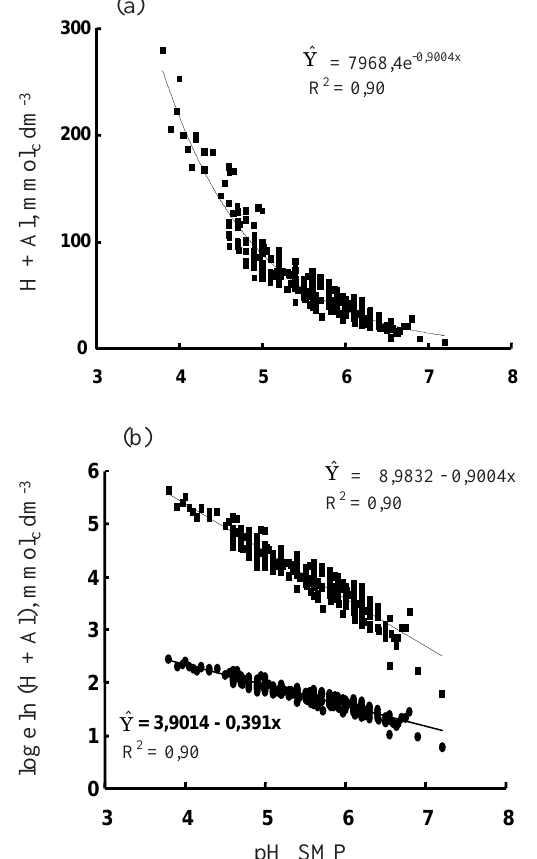
Figura 1. Relação entre a concentração (a) e entre o logaritmo decimal (•) e natural ( ) (b) de H + Al e o pH SMP, em solos do RS e de